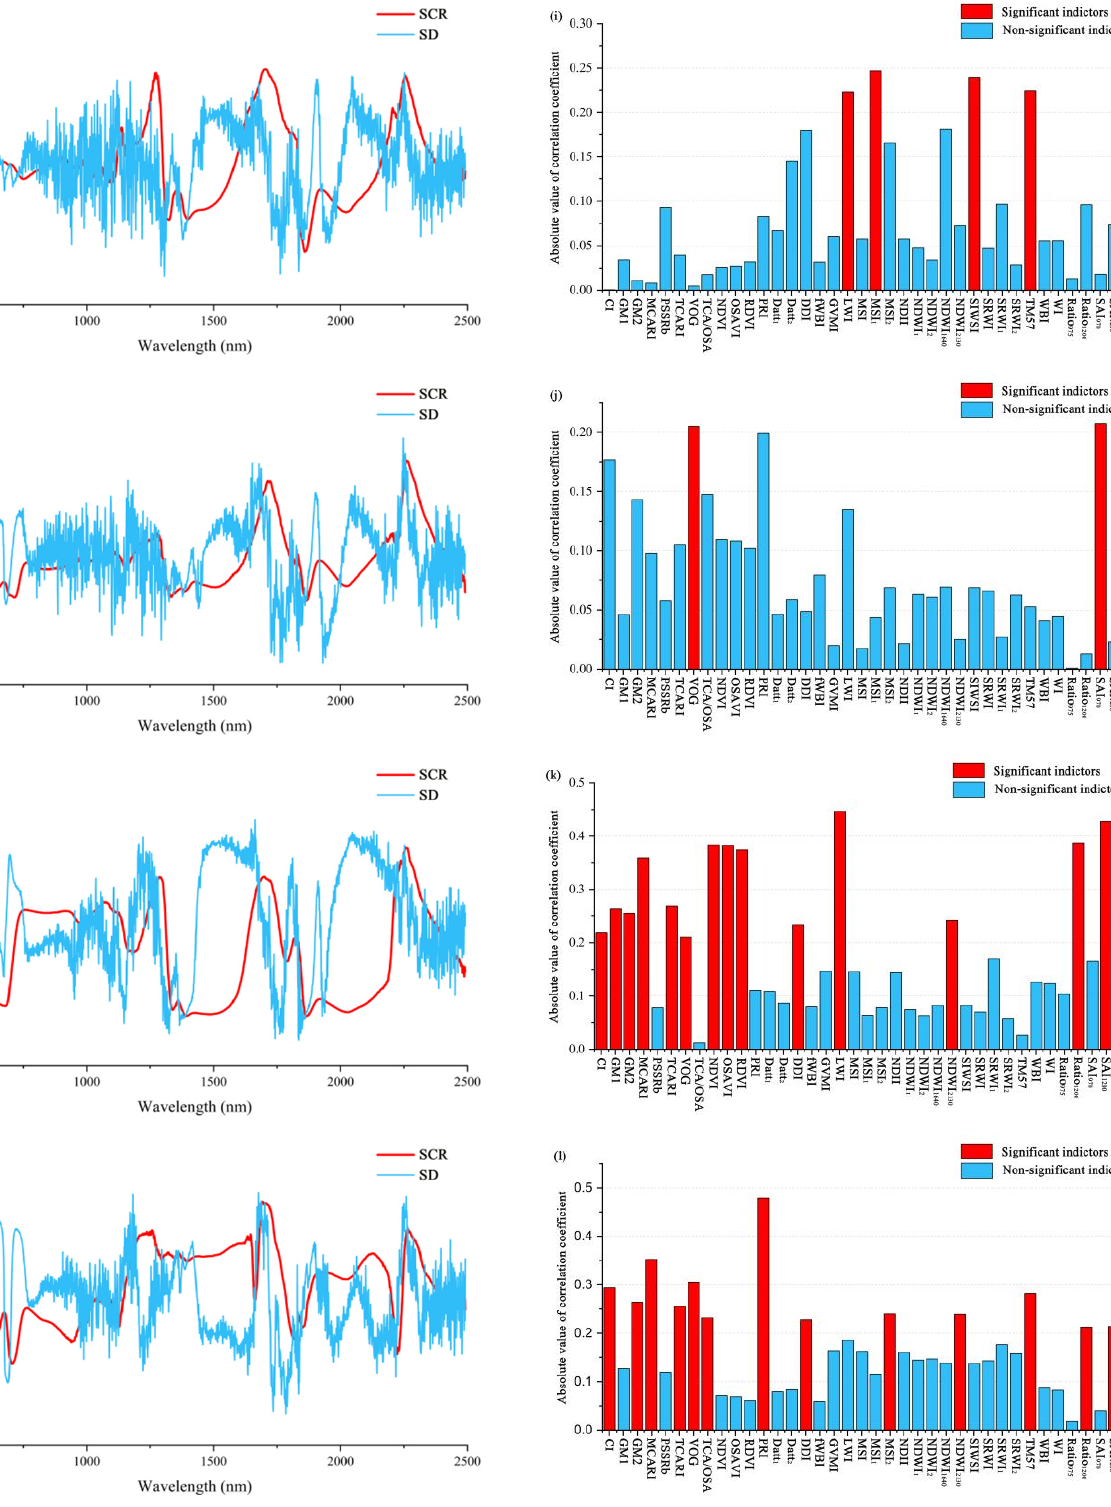
Figure 5. Correlation between spectral features and LWC. ( a – f ) Correlations between spectral data (SCR and SD) and LWC in the entire sample and in H, Mi, Mo, S, and O states, respectively. ( g – l ) Correlations between spectral index and LWC in the entire sample and in H, Mi, Mo, S, and O states, respectively.